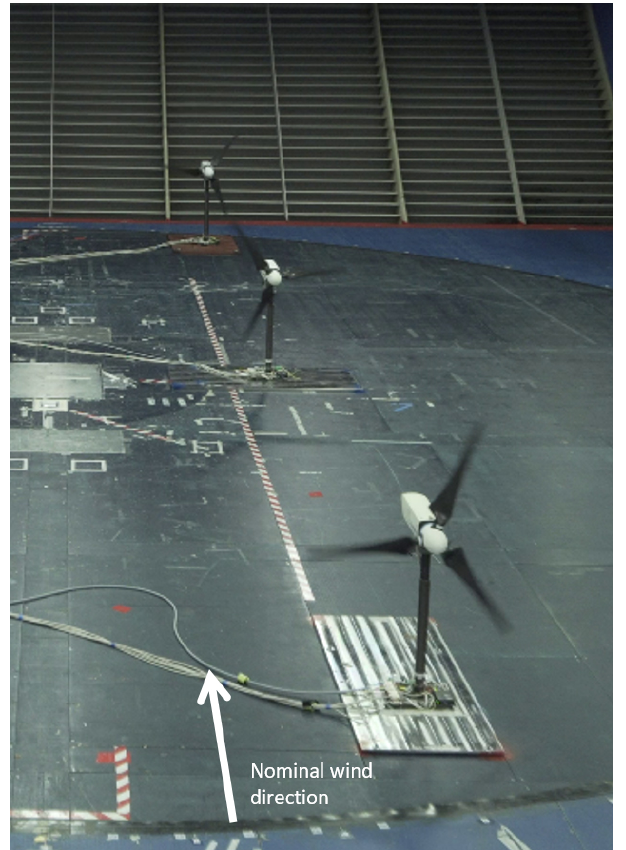
Figure 3. View looking downstream of the cluster of three G1 tur-